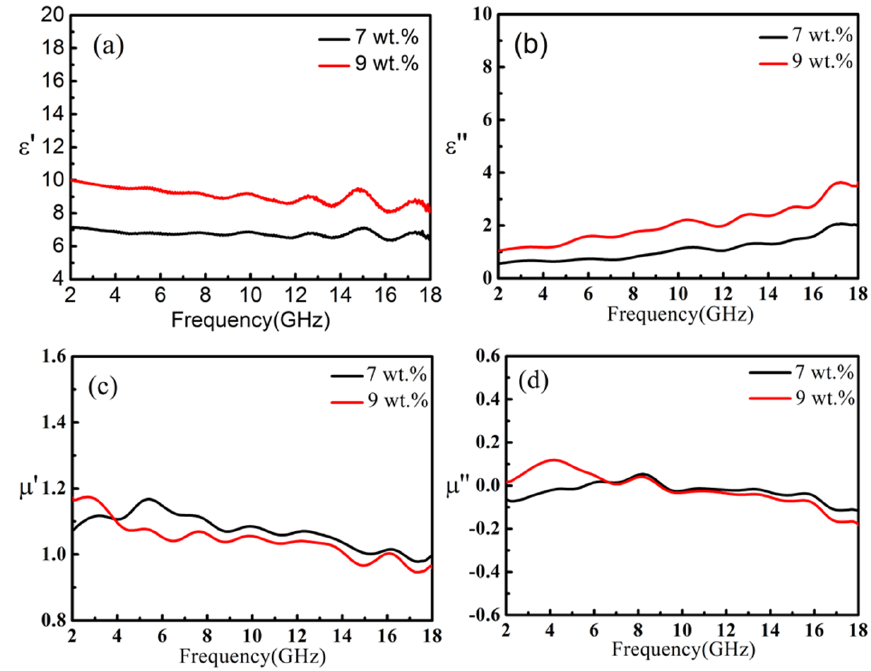
Figure 3. The ε (cid:4593) ( a ), ε (cid:4593)(cid:4593) ( b ), μ (cid:4593) ( c ) and μ (cid:4593)(cid:4593) ( d ) of carbon nanotubes/paraffin samples. Figure 3. The ε (cid:48) ( a ), ε (cid:48)(cid:48) ( b ), µ (cid:48) ( c ) and µ (cid:48)(cid:48) ( d ) of carbon nanotubes/paraffin